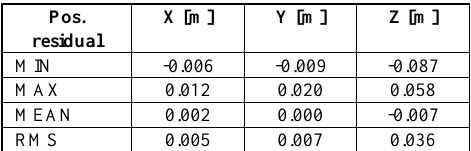
Table 6. Case D: Summary of ISO (AT + 3 close GCPs + 61 relative GNSS + GNSS bias) on 22 checkpoints